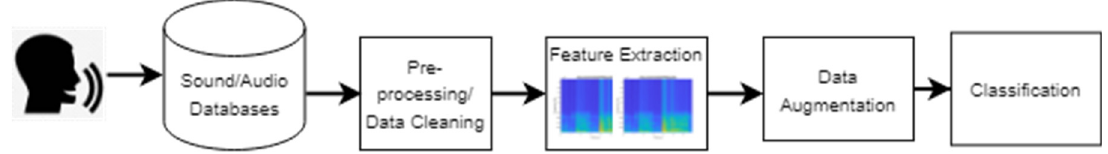
Figure 10. A simple sound classification architecture.